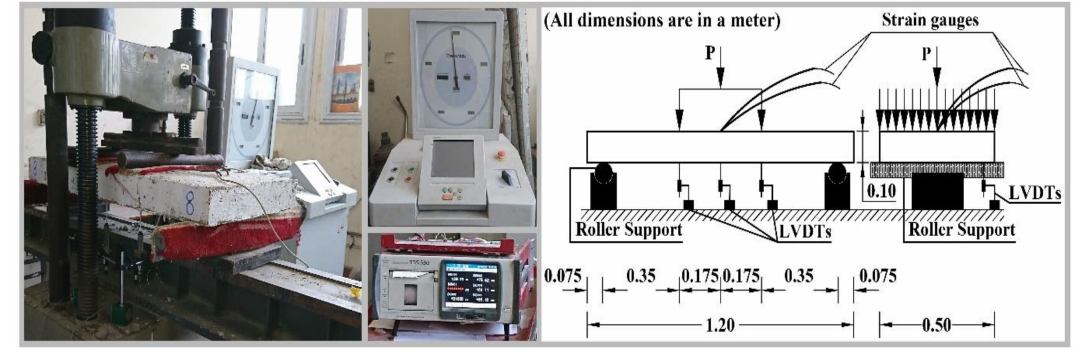
Figure 4. The Shimadzu machine, the computerized data logger, and the test set-up